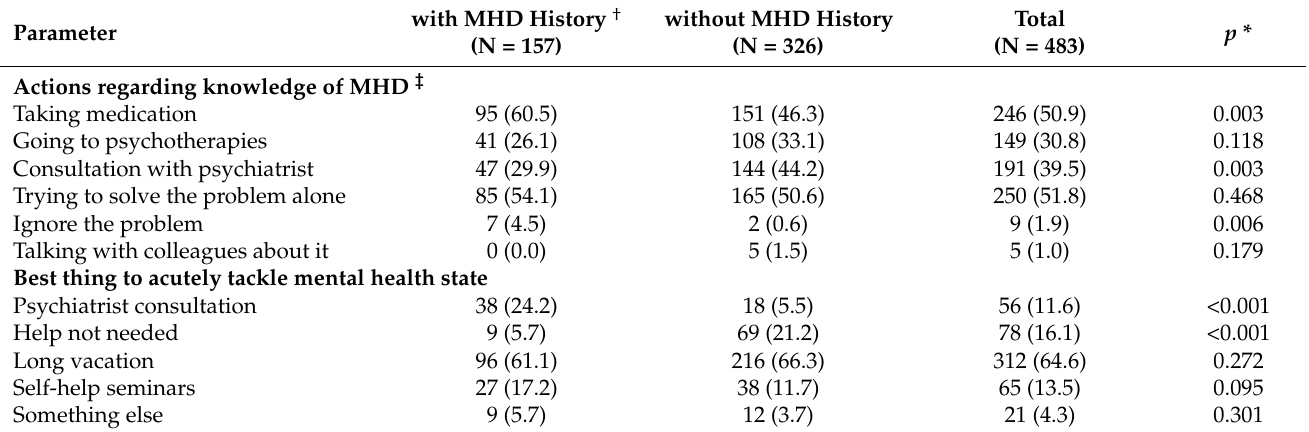
Table 2. Experiences and attitudes on mental health management according to MHD